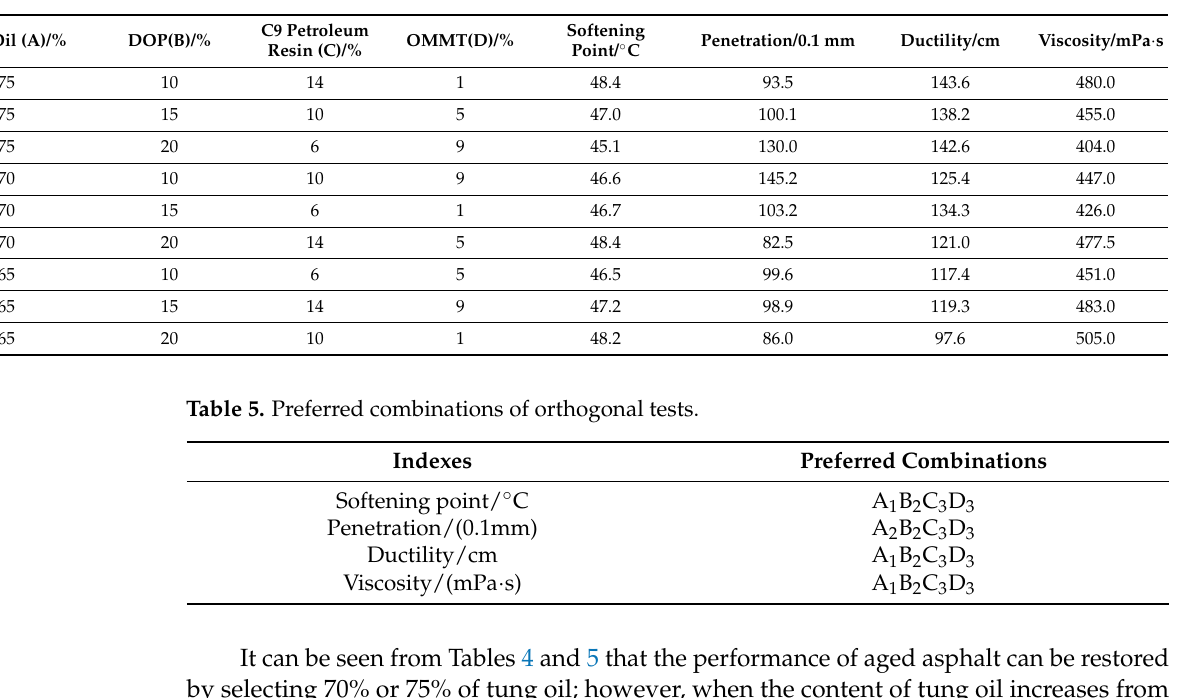
Table 4. Orthogonal test results.